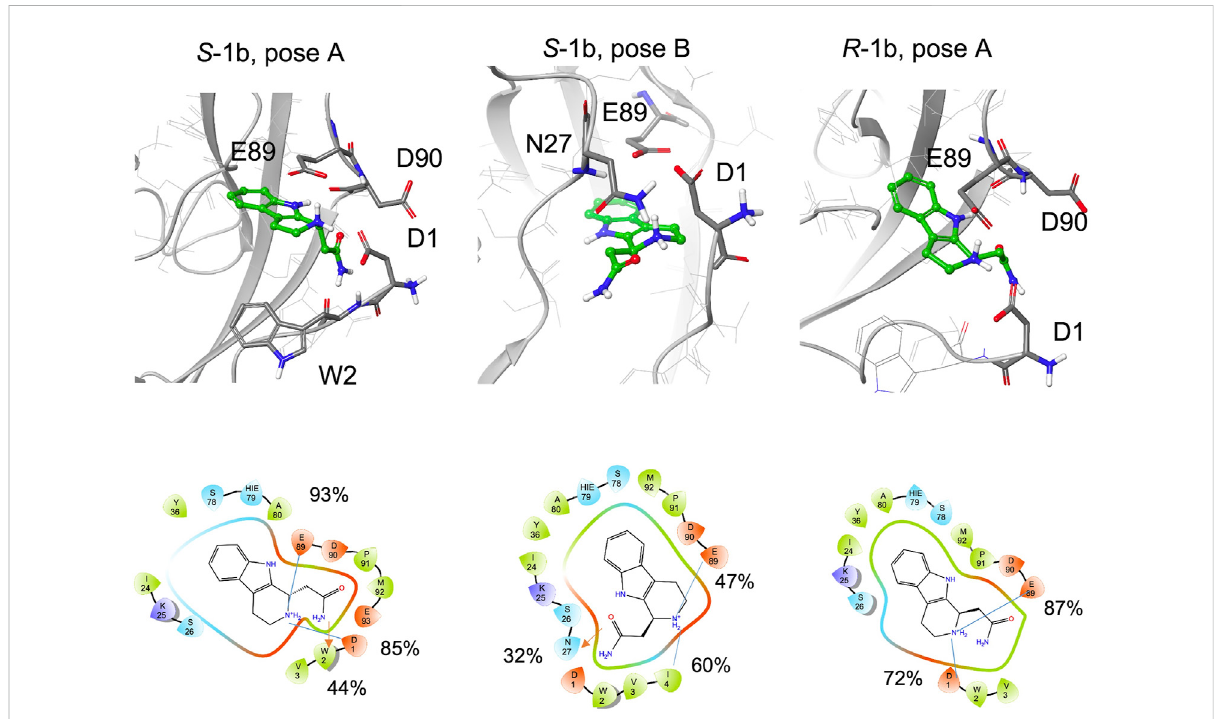
FIGURE 7 Snapshots from MD simulations:. Left S - 1b pose A, middle S - 1b pose B, right R - 1b pose A. The corresponding 2D ligand interaction diagram with the percentages of salt bridges (blue line) and hydrogen bonds (red arrow) monitored during the MD simulations is also